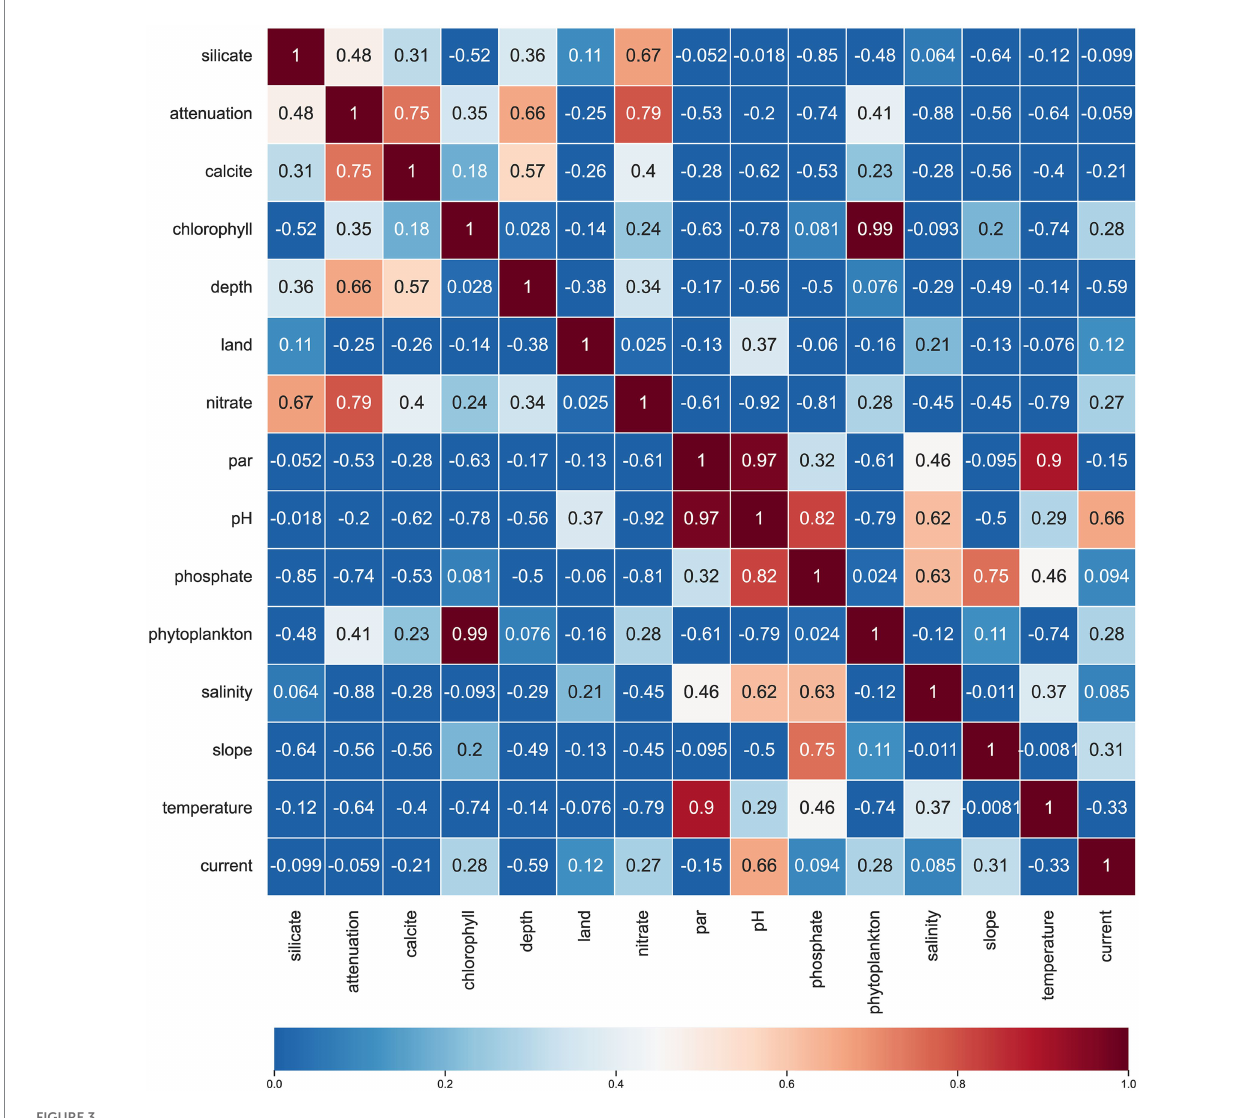
FIGURE 3 Correlation analysis matrix for different environmental